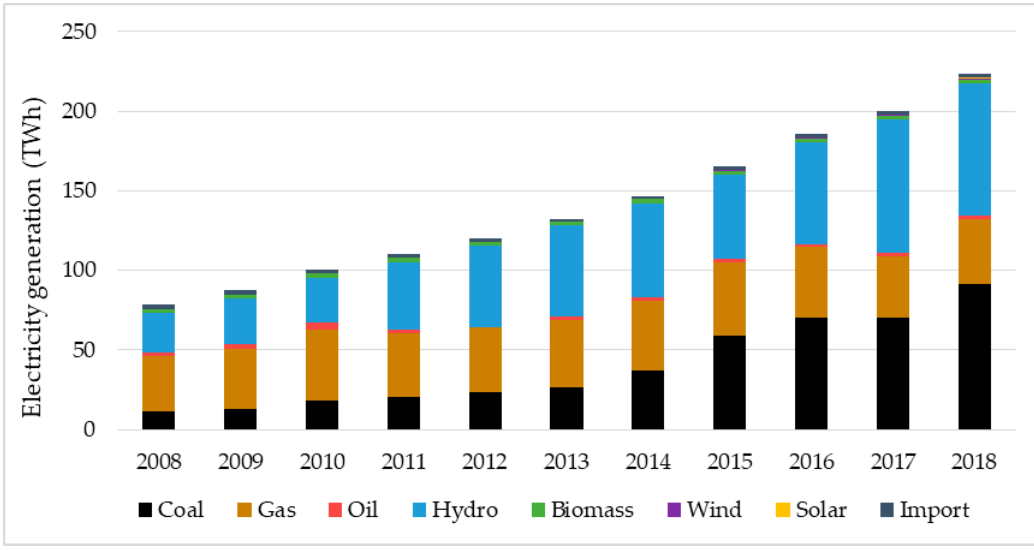
Figure 1. Electricity generation by source by 2018.